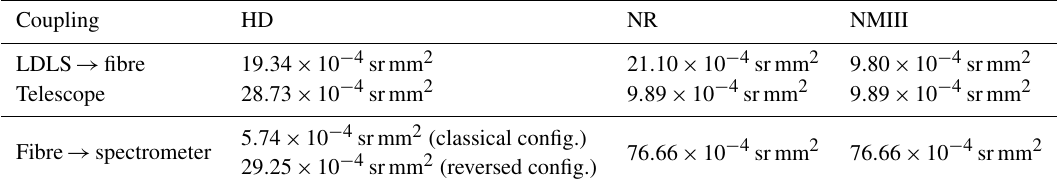
Table 3. Étendues for the coupling between the different components in the three setups used in this study (see Table 1). For setup HD, the spectrometer étendue for two fibre bundle configurations (classical and reversed) are indicated. See Fig. 2 and Sect. 3.3 for a